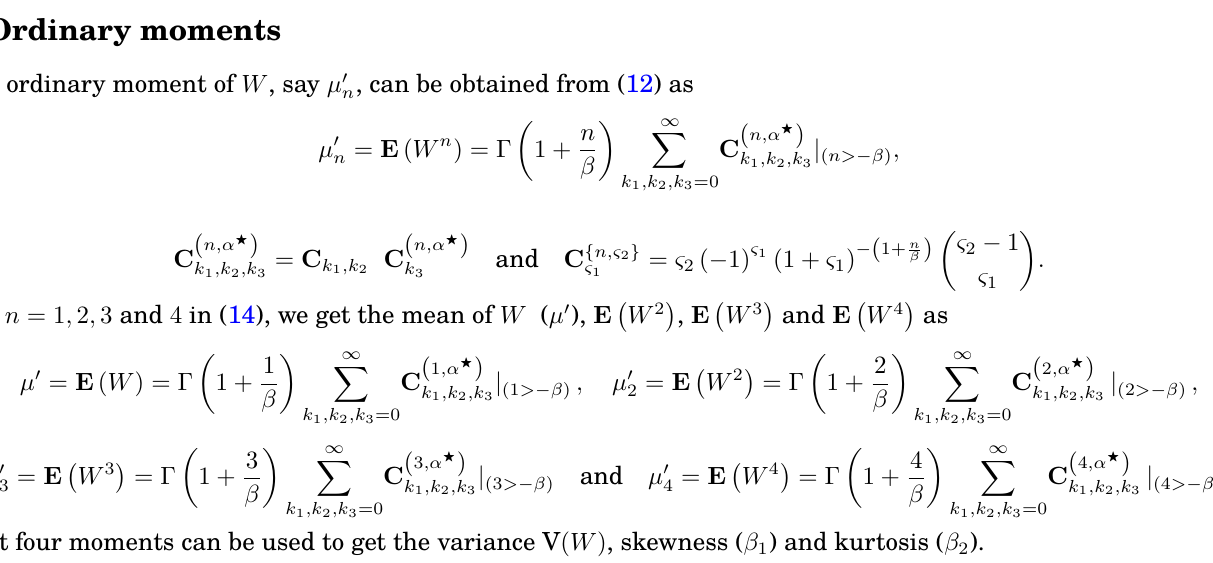
Table 1: Numerical results for µ (cid:48)